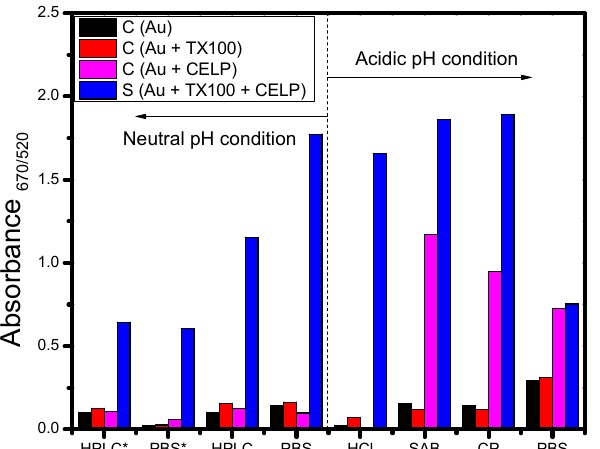
Figure 6. Absorbance ratios of 3 control samples (AuNPs, AuNPs with TX100 or PLA 2 , and AuNPs with liposome) and the sample including AuNPs, TX100 (or PLA 2 ), and liposomes after incubation for 1 h in various buffer media. * indicates the use PLA 2 instead of TX100.